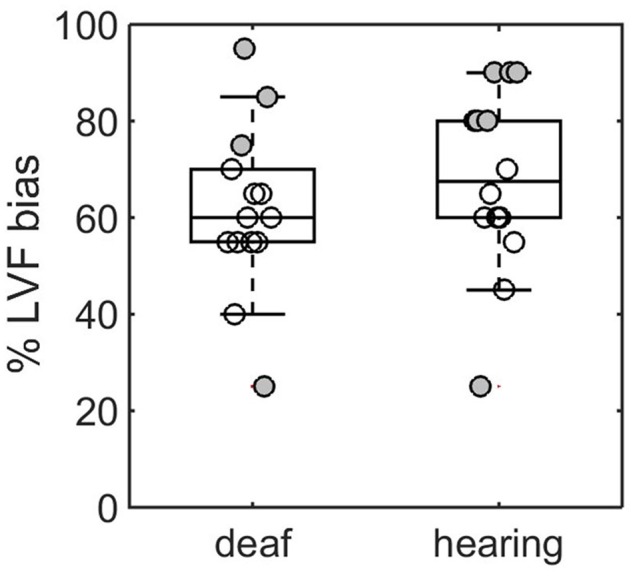
Visual field bias for deaf and hearing participants. Box center and limit give the median, 1st and 3rd quartile. Each data point represents a participant. Filled data points indicate significant bias according to a χ2 statistics. Two participants showed a RVF bias (filled dots < 50%).